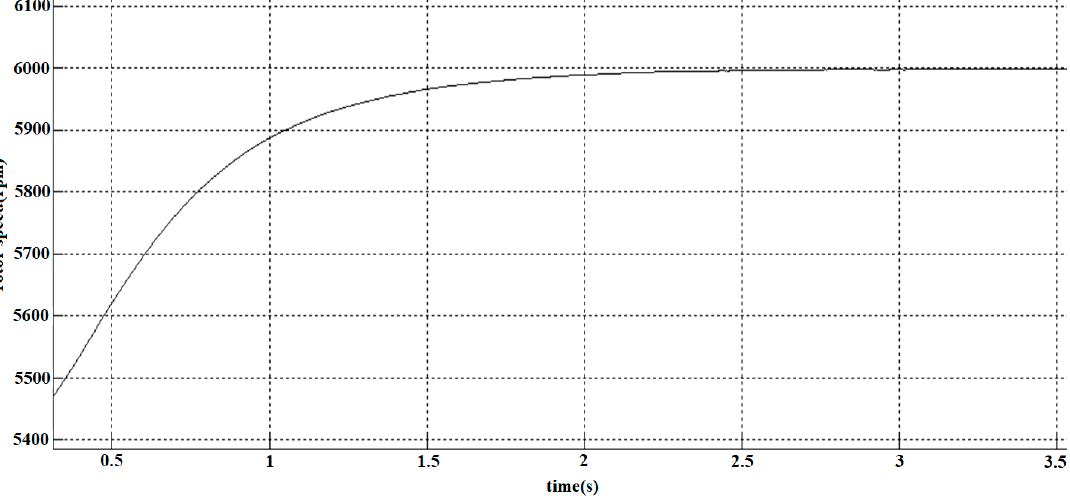
Figure 28. Speed curve of the rotor.